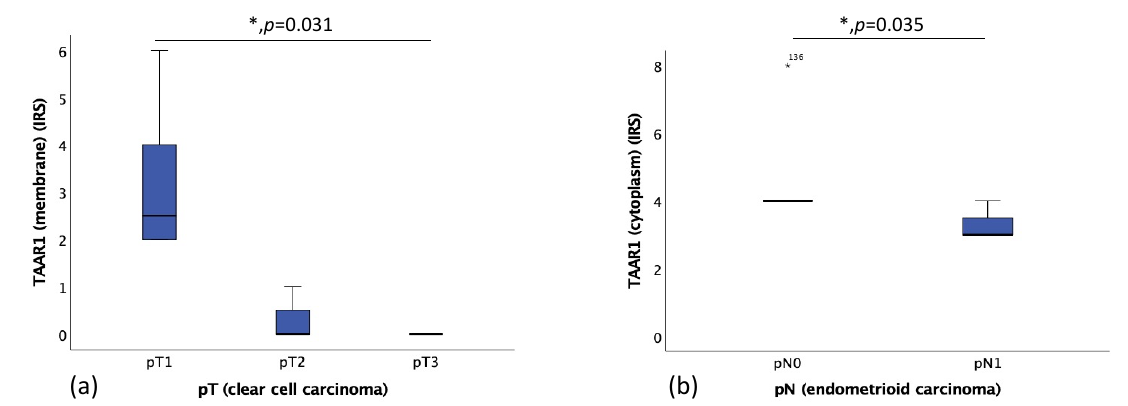
Figure 4. ( a ) Correlation of membrane TAAR1 expression with the size or extent of the primary tumor (pT) in clear cell carcinoma ( p = 0.031), median IRS of pT1 is 2.5 ( n = 6), median IRS of pT2 is 0 ( n = 3), median IRS of pT3 is 0 ( n = 1). ( b ) Correlation of membrane TAAR1 expression with local lymph node status (pN) in endometrioid carcinoma ( p = 0.035), median IRS of pN0 is 4 ( n = 7), median IRS of pN1 is 3 ( n = 3); * p < 0.05 was considered statistically significant.